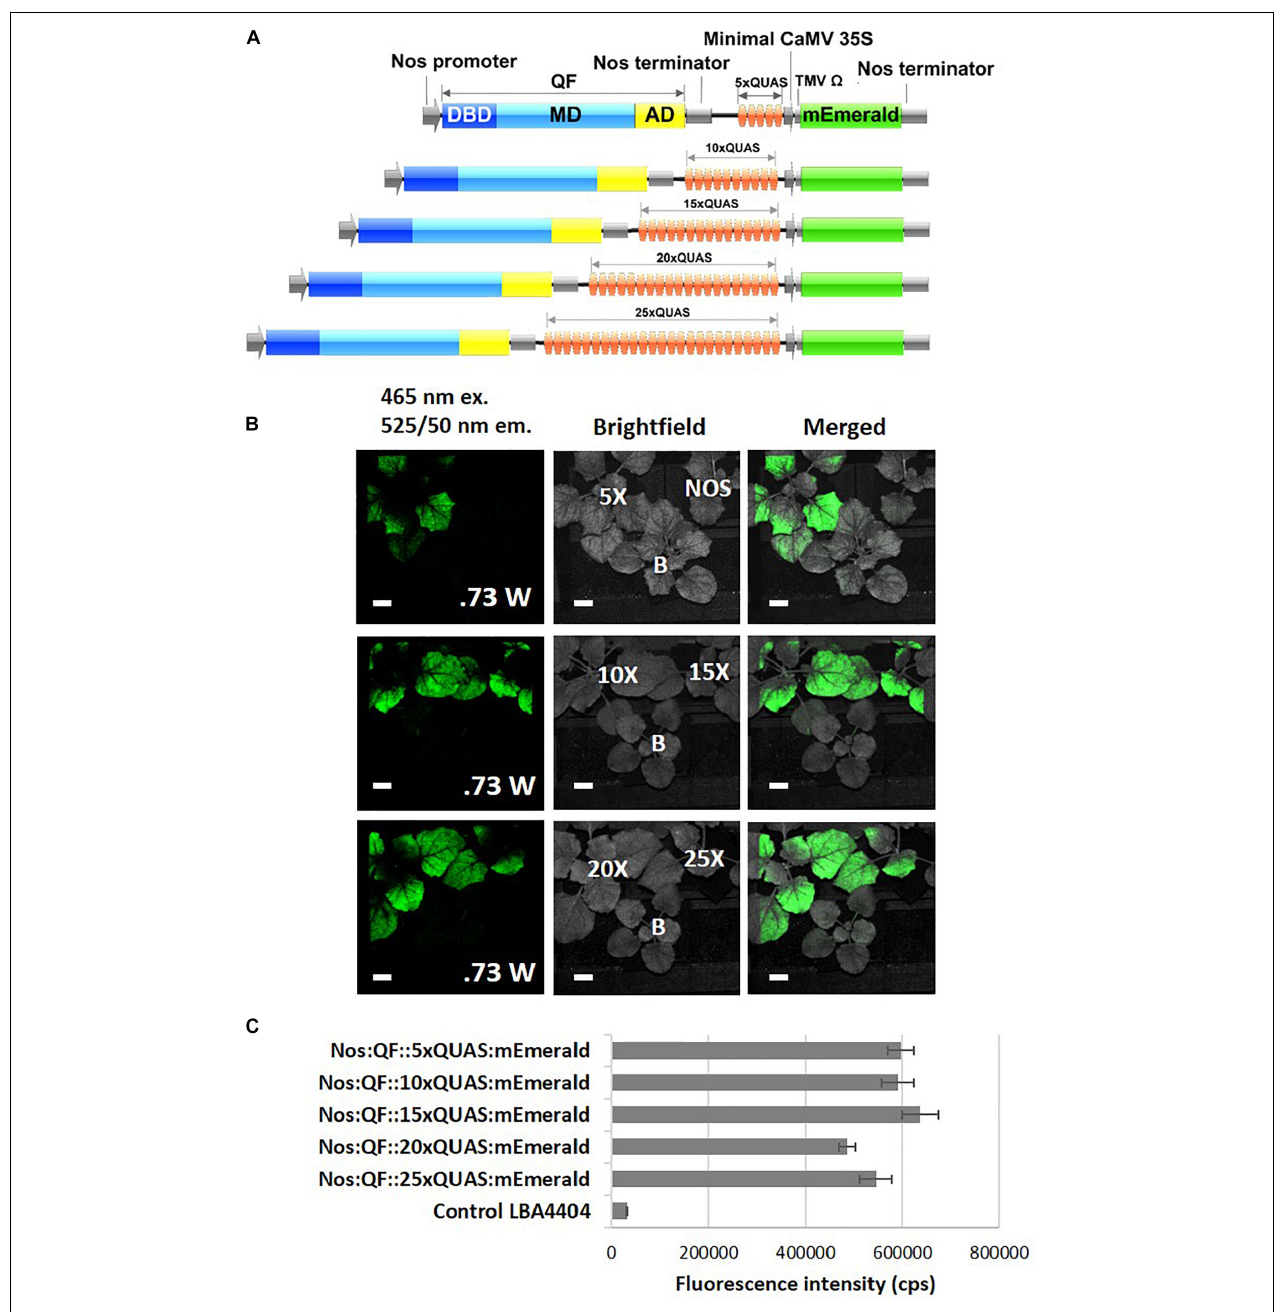
FIGURE 4 | Effect of varying number of QUAS repeats on mEmerald emission. (A) Schematic of QUAS repeat constructs. (B) Images acquired using the FILP system show the ability to detect mEmerald from all QUAS repeats tested; however, the NOS:mEmerald construct without amplification by the Q-system could not be detected. The fluorescent images were acquired using a 150 ms exposure time. (C) Spectral analysis of mEmerald emission readings at 509 nm. Statistical significant differences between groups determined using one-way ANOVA with post hoc analysis using Tukey HSD: groups with different letters show a significant difference ( p < 0.05). Error bars, standard error of mean. Scale bar: 2.5 cm. The brightfield image is labeled for each of the QUAS repeats tested, the empty vector negative control, labeled (B) , and the Nos:mEmerald positive control. Data represent mean ± standard error of three independent experiments ( n = 3). Three technical replicates were collected for each biological replicate to account for positional